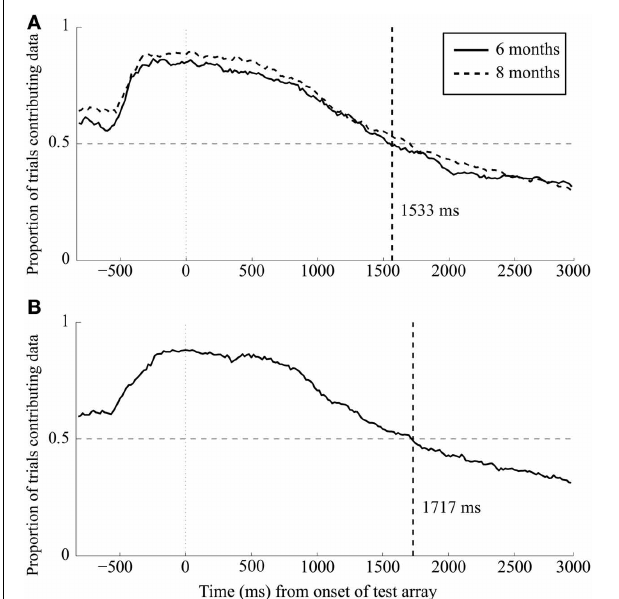
FIGURE 2 | Proportion of trials with looks to the left or right AOI at each sample for 6- and 8-month-old infants in Experiment 1 (panel A) and 6-month-old infants in Experiment 2 (panel B). Note that for all samples, the proportion of trials with looks increases dramatically over the pre-change period (from − 833 to 0ms), and then begins to decrease during the post-change period. The dashed vertical line indicates the 50% cut-off used to determine the end of the analysis window used in each